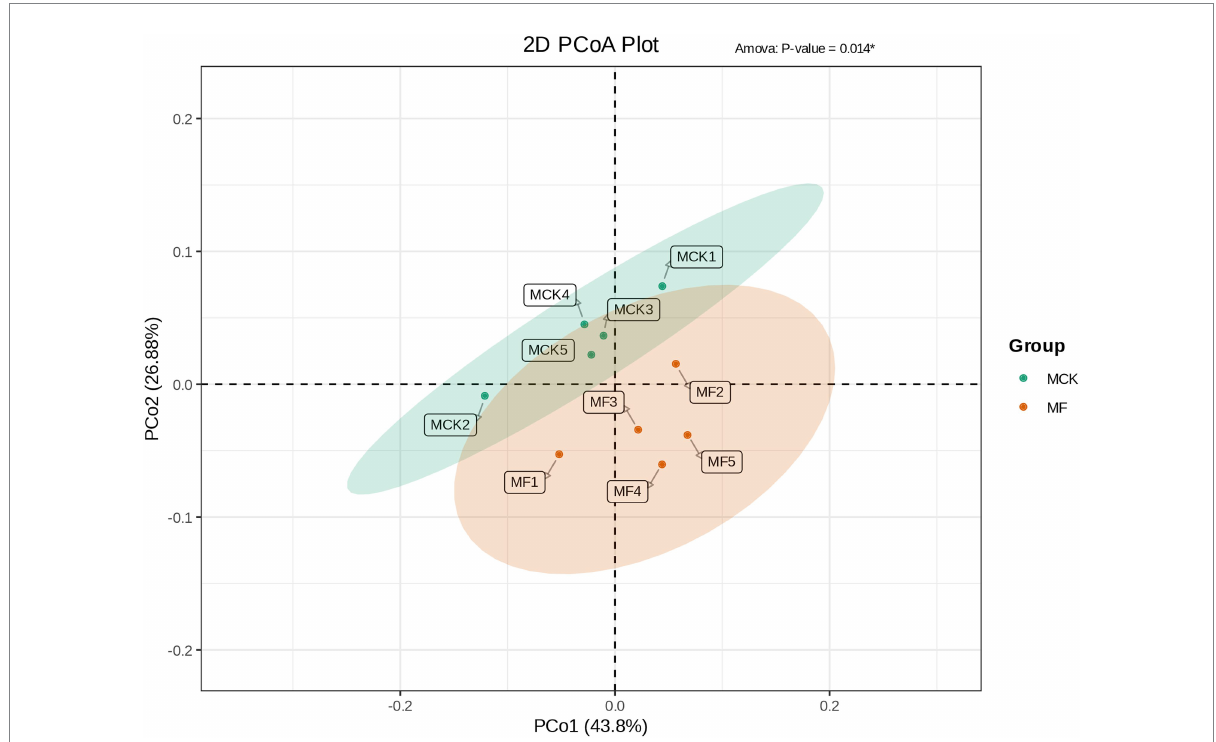
FIGURE 3 PCoA based on the bacterial composition showing the distribution of each group samples and differences between the groups (MCK and